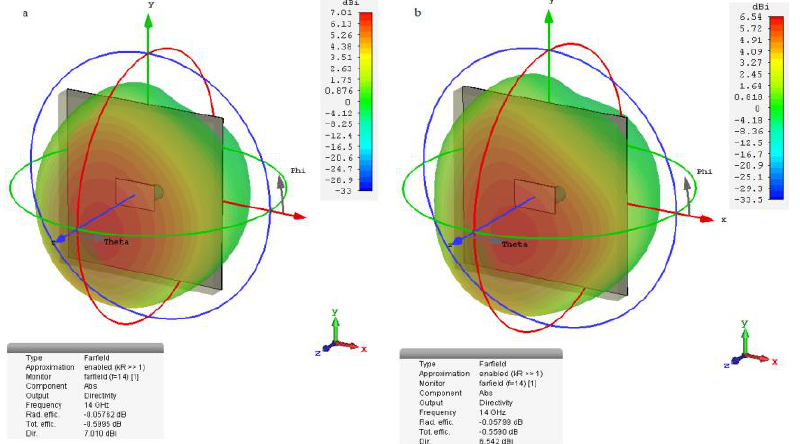
Fig. 3. Space radiation patterns of printed emitters without distributed excitation (a) and with distributed excitation (b).